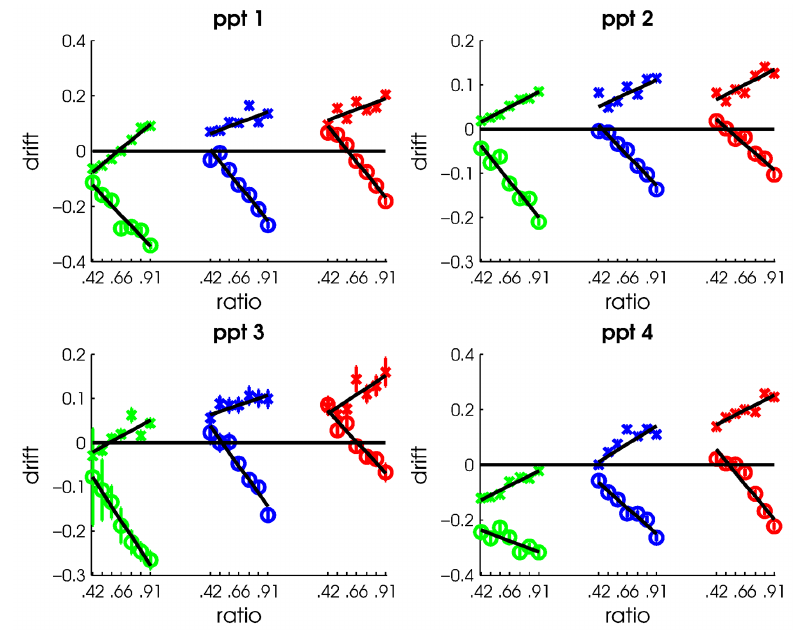
Figure 5. Graphical representation of drift rate for each of the four participants, abbreviated 'ppt'. The horizontal line for the drift represents the level at which the drift is 0. The green symbols are for conditions for which the standard was smaller (12 dots), the blue symbols are for conditions for which the standard was medium (24 dots), the red symbols are for conditions for which the standard was big (36 dots). 'o' for conditions for which the CRC was smaller, 'x' for conditions for which the CRC was bigger. All ratios are reported, even though on the x label are labelled only the two extreme ratio conditions (.42 and .91) and the .66 ratio conditions. Error bars are standard errors of parameters' estimates recovered by